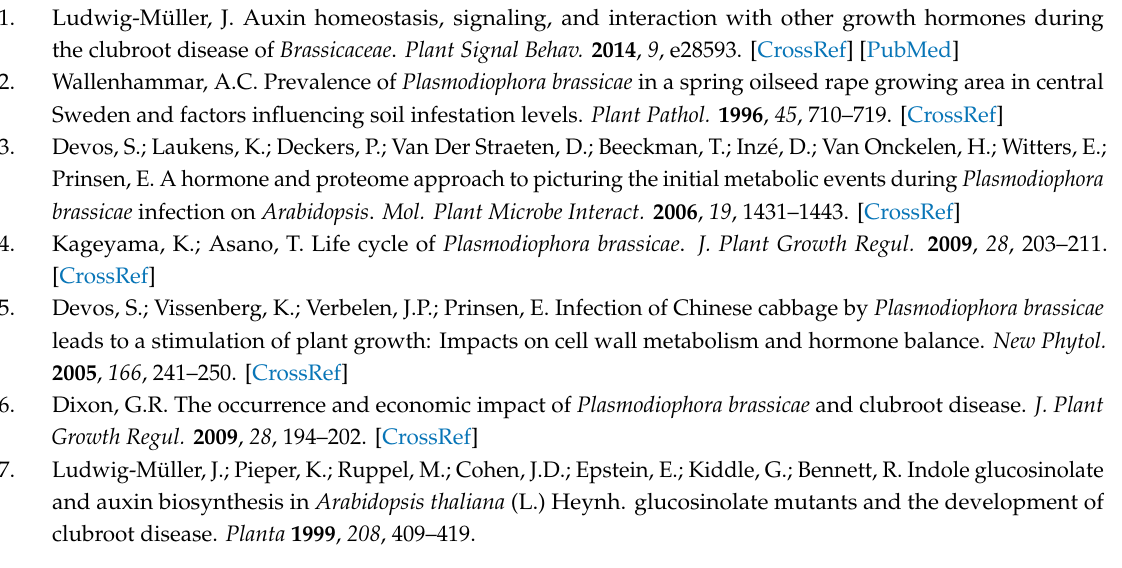
Figure S1. Phylogenetic tree showing association between auxin biosynthesis genes (black) in Arabidopsis thaliana and orthologues in Brassica rapa . Di ff erent colour codes of B. rapa genes represent di ff erent protein / gene families. BrGH3—violet, BrIAA—light blue, BrSAUR—green, BrPIN—orange, BrARG10like—yellow, BrLAX—pink, BrPILS—dark red, BrGH3—light green, BrNIT- chocolate, BrDCK-Red and BrARP—dark blue, Table S1. Protein homology analysis of 23 genes involved in auxin metabolism, signaling, and transport in Brassica